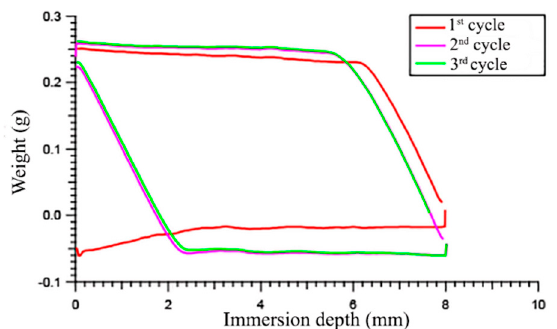
Figure 2. Wilhelmy plate force-immersion depth curves for the polymer S27SzA11: three cycles of immersion, 8 mm depth/10 s dwell time. Table 2. Advancing and receding contact angles for S27SzAn block copolymers and the respective homopolymer.